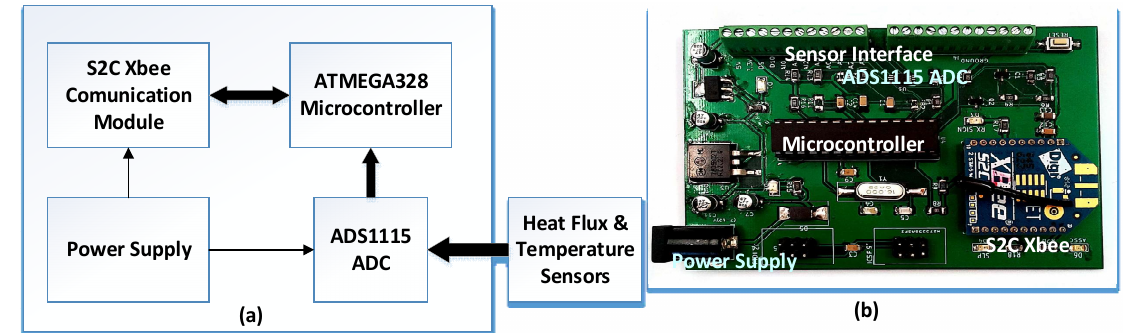
Figure 2. Sensor node, ( a ) block diagram, and ( b ) prototype.